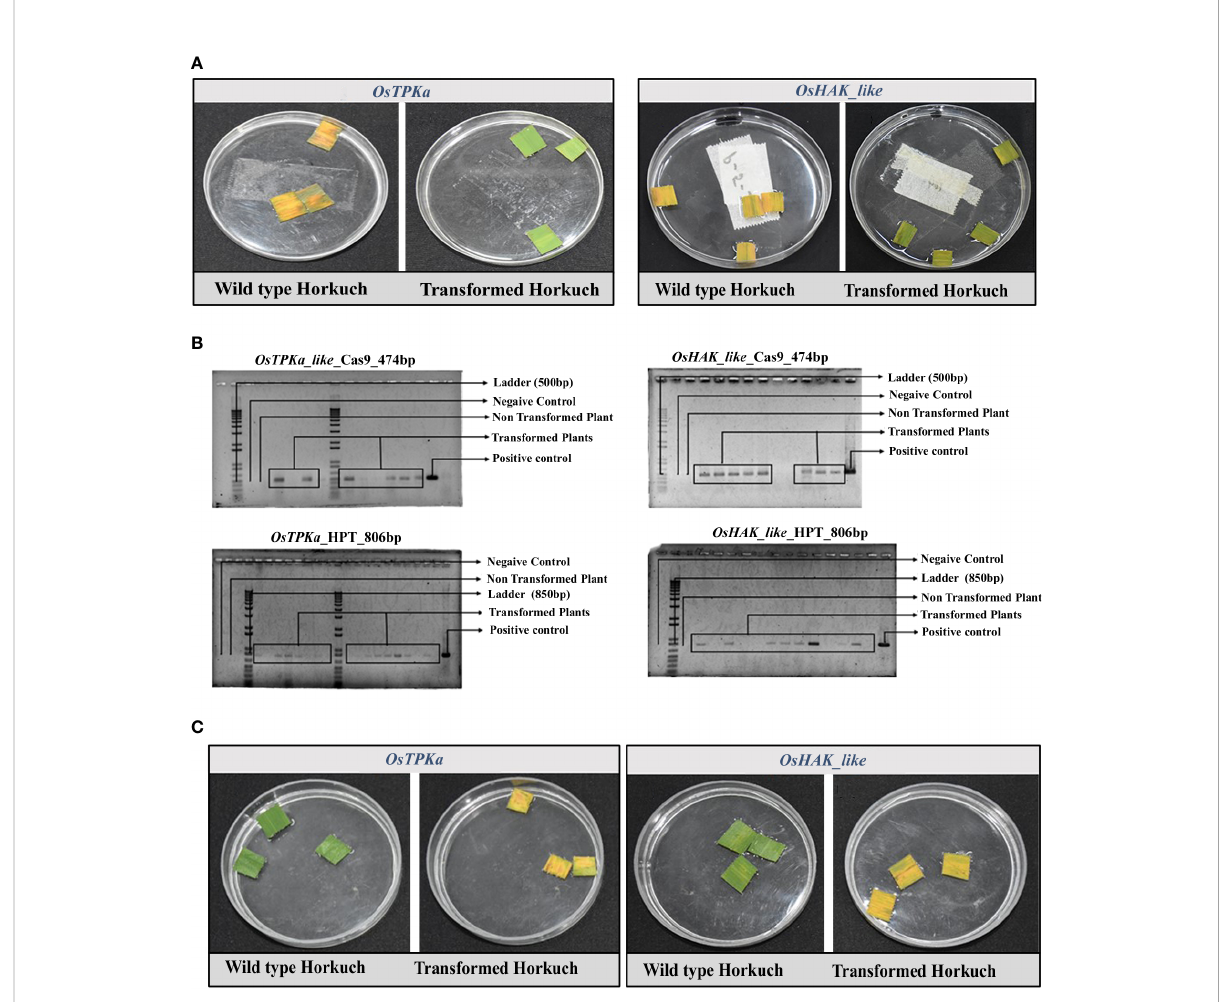
FIGURE 4 (A) Hygromycin resistance assay of T 0 transformants. The wild type became yellow, but the positive transgenic lines remain green in presence of hygromycin, (B) molecular con fi rmation of transformed plants by targeting Cas9 and hptII gene. The lines with the PCR bands are the positive transgenic lines, wild type showed no such bands; (C) Leaf disc senescence assay of fl ag leaves from both OsTPKa_sgRNA and OsHAK_like_sgRNA